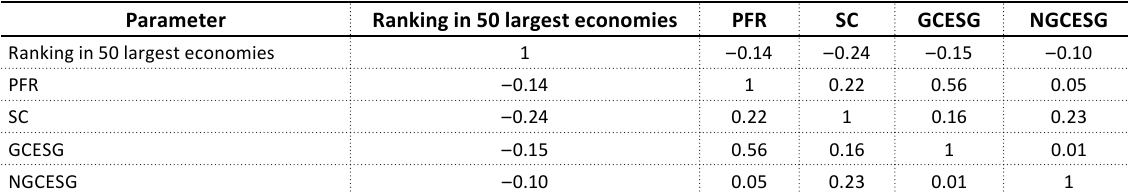
Table D1. Correlation analysis of ESG disclosure regulation and overall competitiveness of the countries: case of all data set